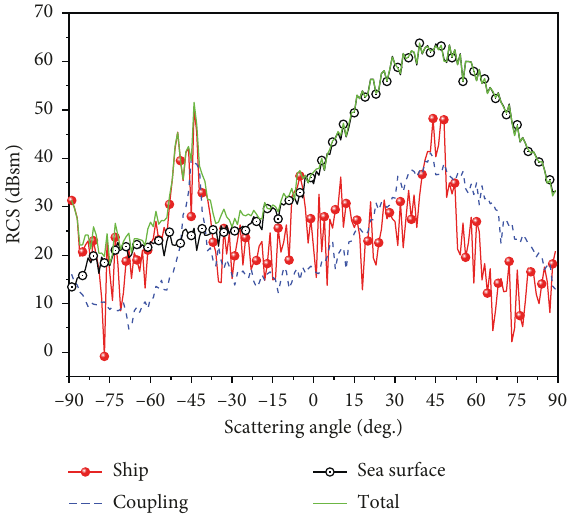
Figure 10: The scattering contributions from the ship and sea surface.